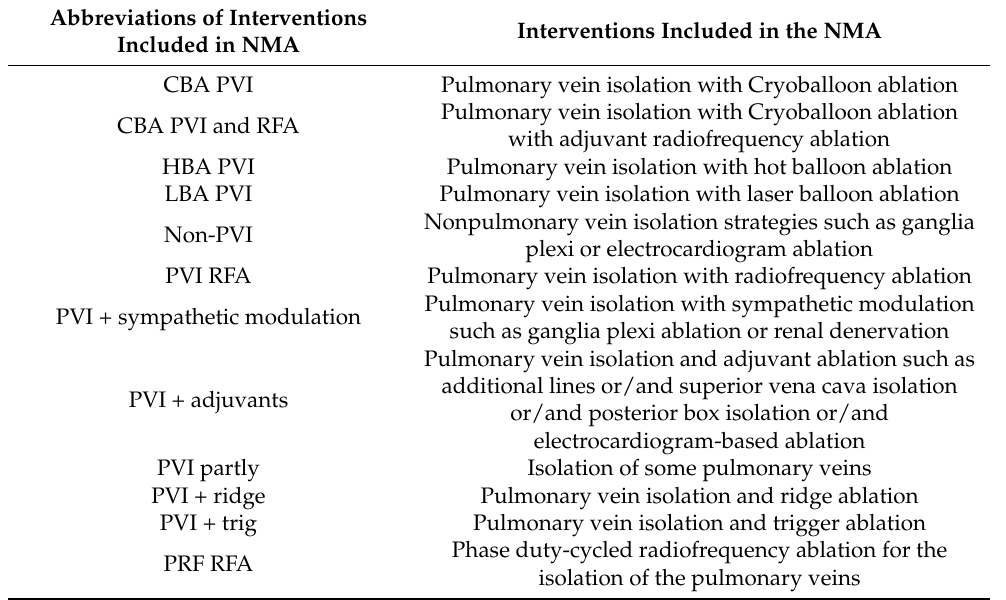
Table 1. Interventions included in NMA (and their abbreviations). Abbreviations of Interventions Interventions Included in the NMA Included in NMA CBA PVI Pulmonary vein isolation with Cryoballoon ablation Pulmonary vein isolation with Cryoballoon ablation CBA PVI and RFA with adjuvant radiofrequency ablation HBA PVI Pulmonary vein isolation with hot balloon ablation LBA PVI Pulmonary vein isolation with laser balloon ablation Nonpulmonary vein isolation strategies such as ganglia Non-PVI plexi or electrocardiogram ablation PVI RFA Pulmonary vein isolation with radiofrequency ablation Pulmonary vein isolation with sympathetic modulation PVI + sympathetic modulation such as ganglia plexi ablation or renal denervation Pulmonary vein isolation and adjuvant ablation such as additional lines or/and superior vena cava isolation PVI + adjuvants or/and posterior box isolation or/and electrocardiogram-based ablation PVI partly Isolation of some pulmonary veins PVI +